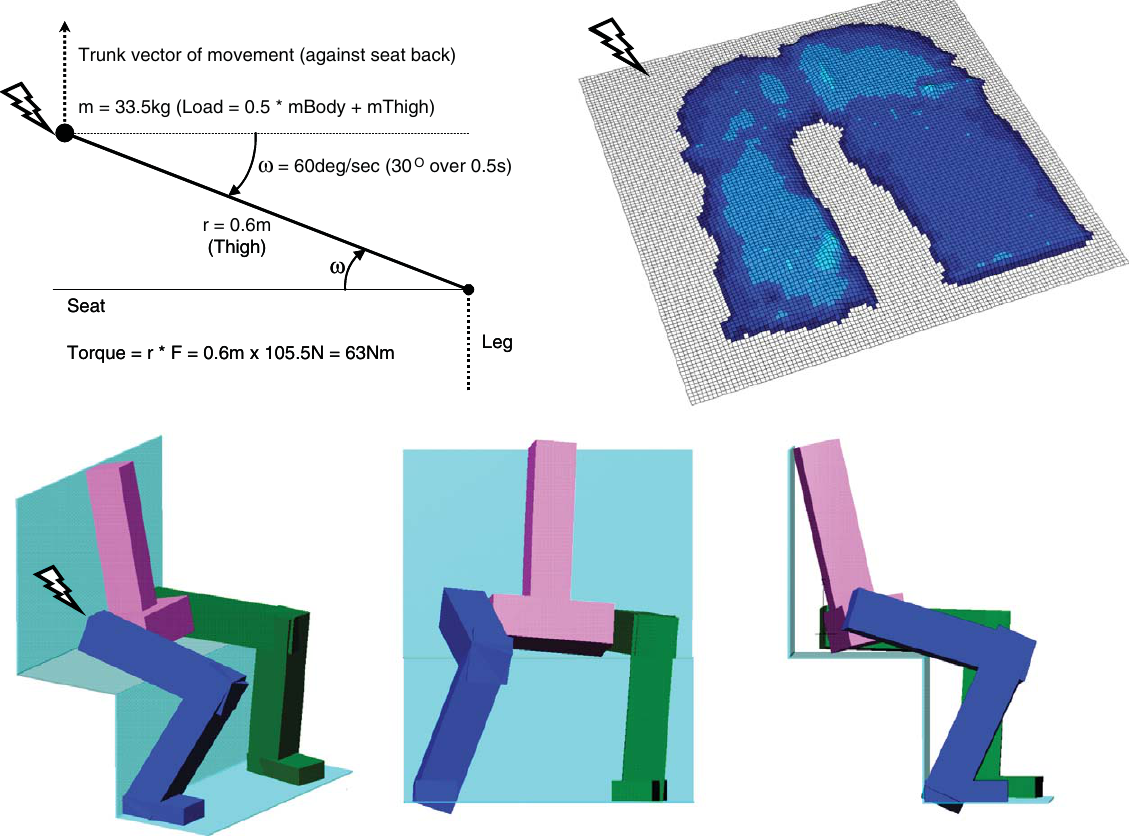
Fig. 1. Rigid body analysis of R. hip extension torque, for extreme unloading. Note unloading under ipsilateral buttock (and contralateral buttock to a lesser degree). This simulates well the experimental findings from surface stimulation interface maps (inset right and Fig.